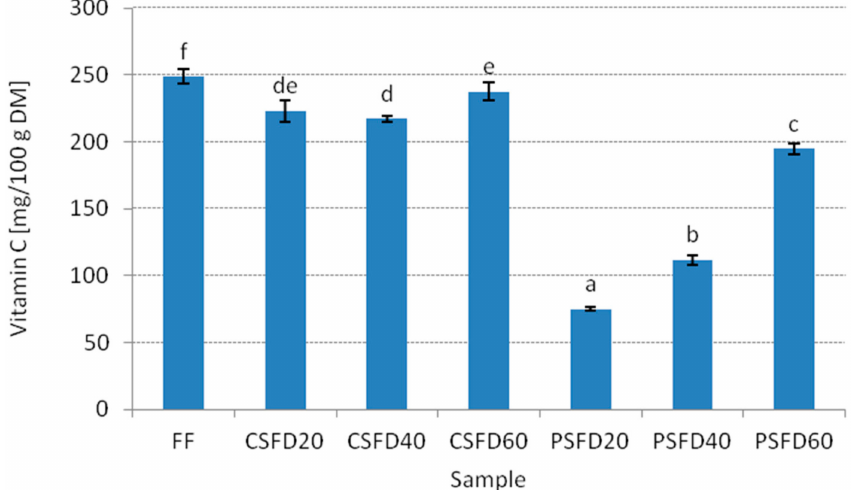
Figure 4. Ascorbic acid content in fresh fruits and freeze-dried strawberry slices (CS) dehydrated at 20 ◦ C (CSFD20), 40 ◦ C (CSFD40), and 60 ◦ C (CSFD60), and freeze-dried strawberry pulp (PS) dehydrated at 20 ◦ C (PSFD20), 40 ◦ C (PSFD40), and 60 ◦ C (PSFD60). The values designated by different lower case letters (a–f) are significantly different ( α =